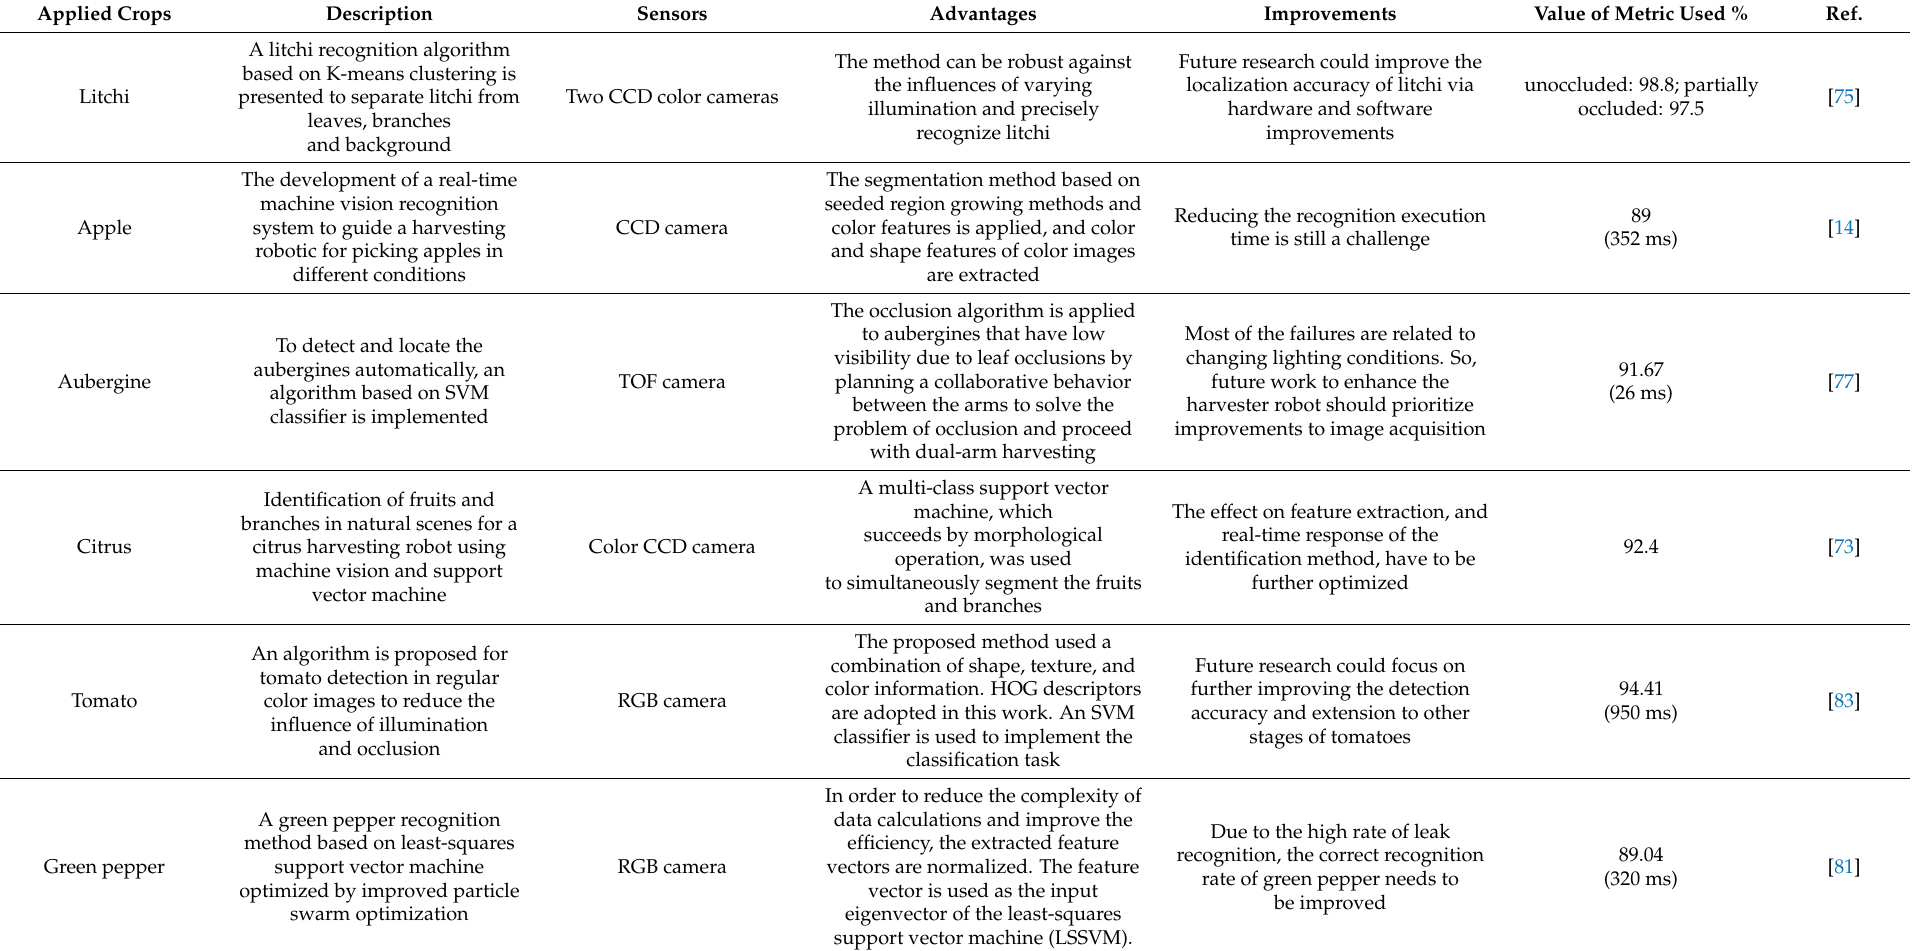
Table 3. Comparison of techniques based on traditional machine